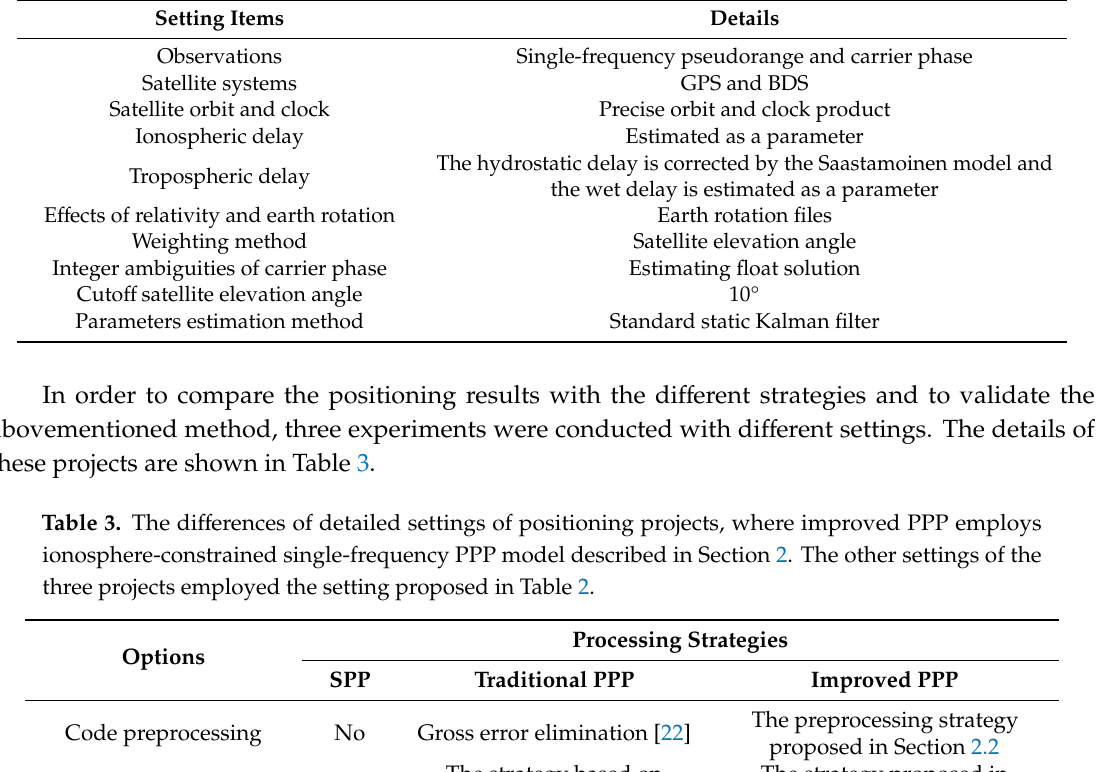
Table 2. The detailed settings of the PPP with smartphone.